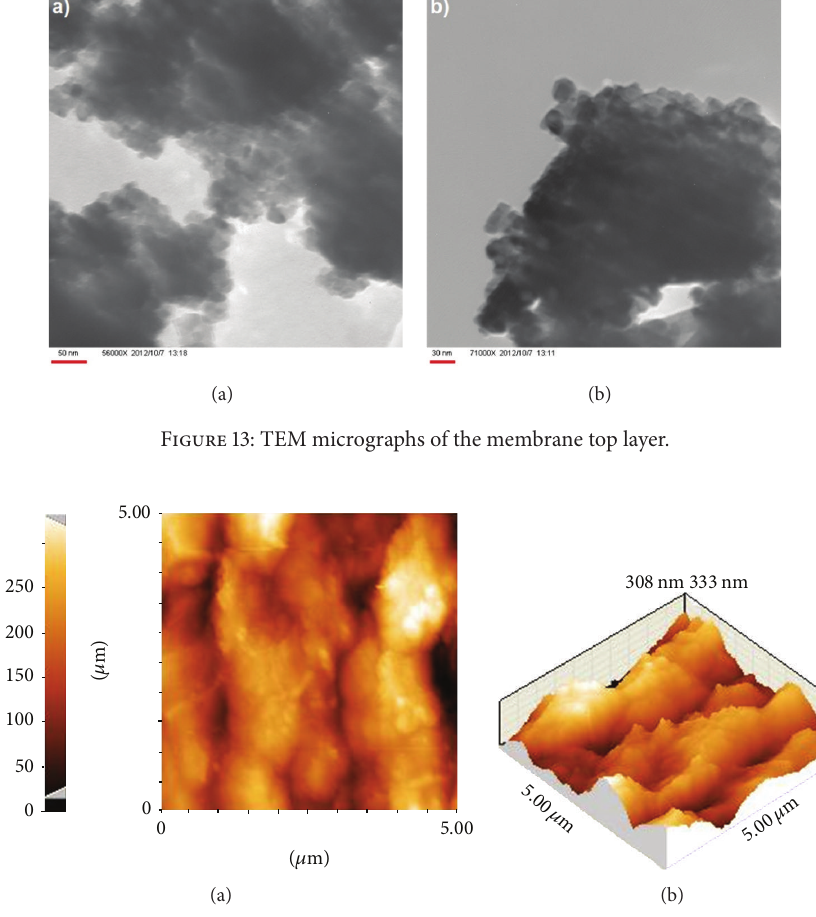
Figure 14: AFM micrographs (a) 2D and (b) 3D of the surface morphology of the nanostructured anatase membrane.